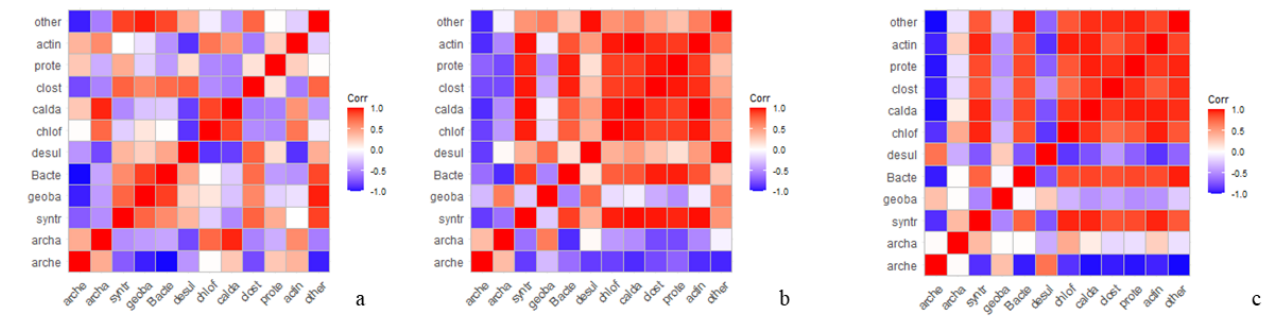
Figure 8. Correlation matrixes for OTUs sampled in control ( a ), PAC ( b ) and graphene ( c ) experi- ments. OTUs are shortened as follows; arche: ca. methanofastidiosum, archa: methanogens, syntr: syntrophic taxa, geoba: geobacter, desul: desulfobacterota, calda: caldatribacteriota, prote: proteo- bacteria, actin. actinobacteriota, bacte: bacteria, chlof: chloroflexi, clost: clostridi. (Pearson correla- tion coefficient, n = 6).